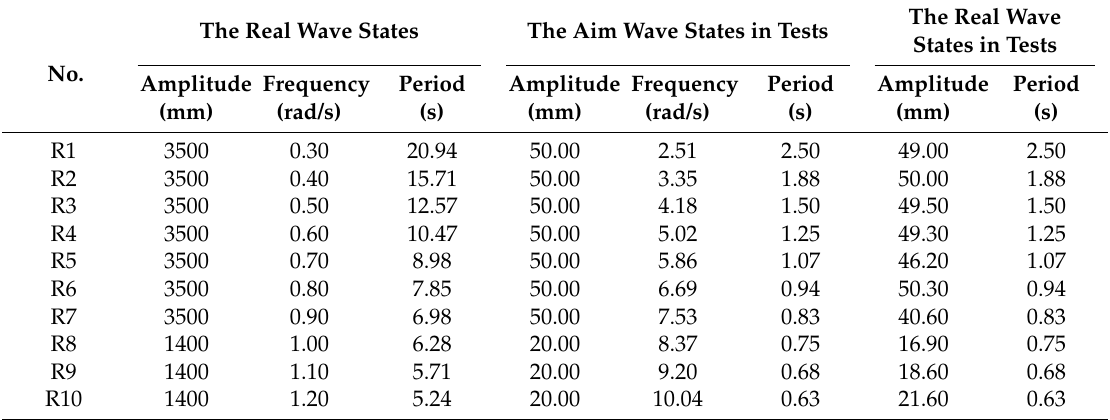
Table 3. Regular wave parameters used in the